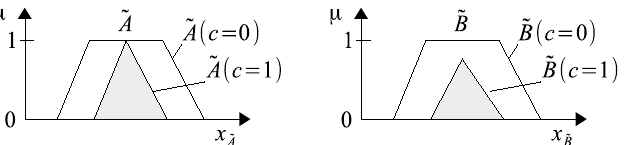
Figure 40. Example of normal T2FN ˜ A with normal support FN ( ˜ A ( c = 0 ) ) and normal core FN ( ˜ A ( c = 1 ) ), and example of non-normal T2FN ˜ B with non-normal core-FN ( ˜ B ( c = 1 ) ). Knowledge of how to perform calculations on normal T2FNs will greatly facilitate the development of T2FA for non-normal T2FNs. Non-normal T2FNs may arise (as representa- tion of expert knowledge) when there are strong differences in a group of many experts in the estimation of uncertain values of